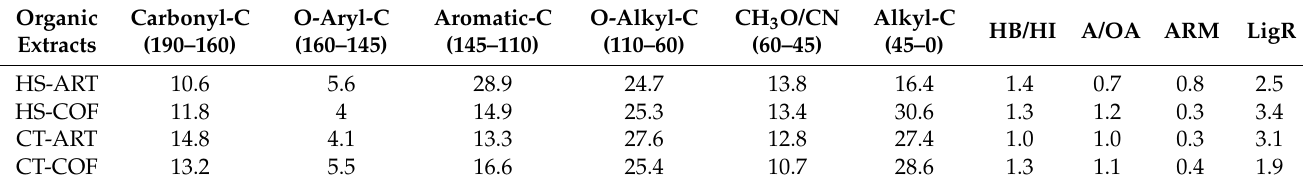
Figure 1. 13 C-CPMAS-NMR spectrum of humic substances and relative compost tea from artichoke and coffee composted biomasses (HS-ART, HS-COF, CT-ART, CT-COF). Table 1. Relative distribution (%) of main C structures over chemical shift regions (ppm) and structural indices a of humic substances (HS) and compost teas (CT) as measured by 13 C CPMAS- NMR